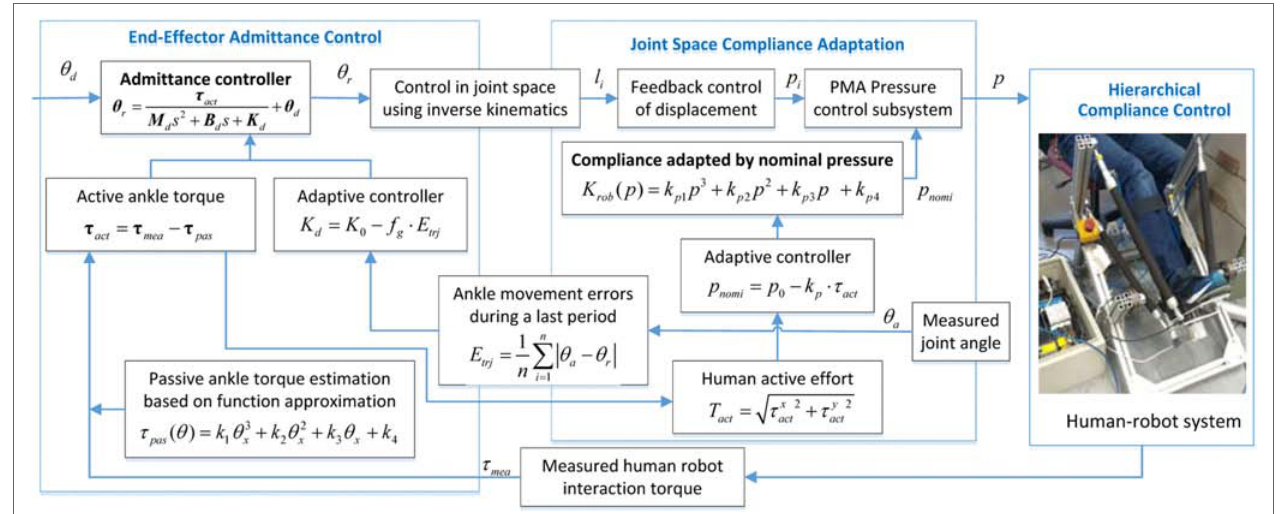
FIGURE 7 | Adaptive hierarchical compliance controller for the ankle rehabilitation robot